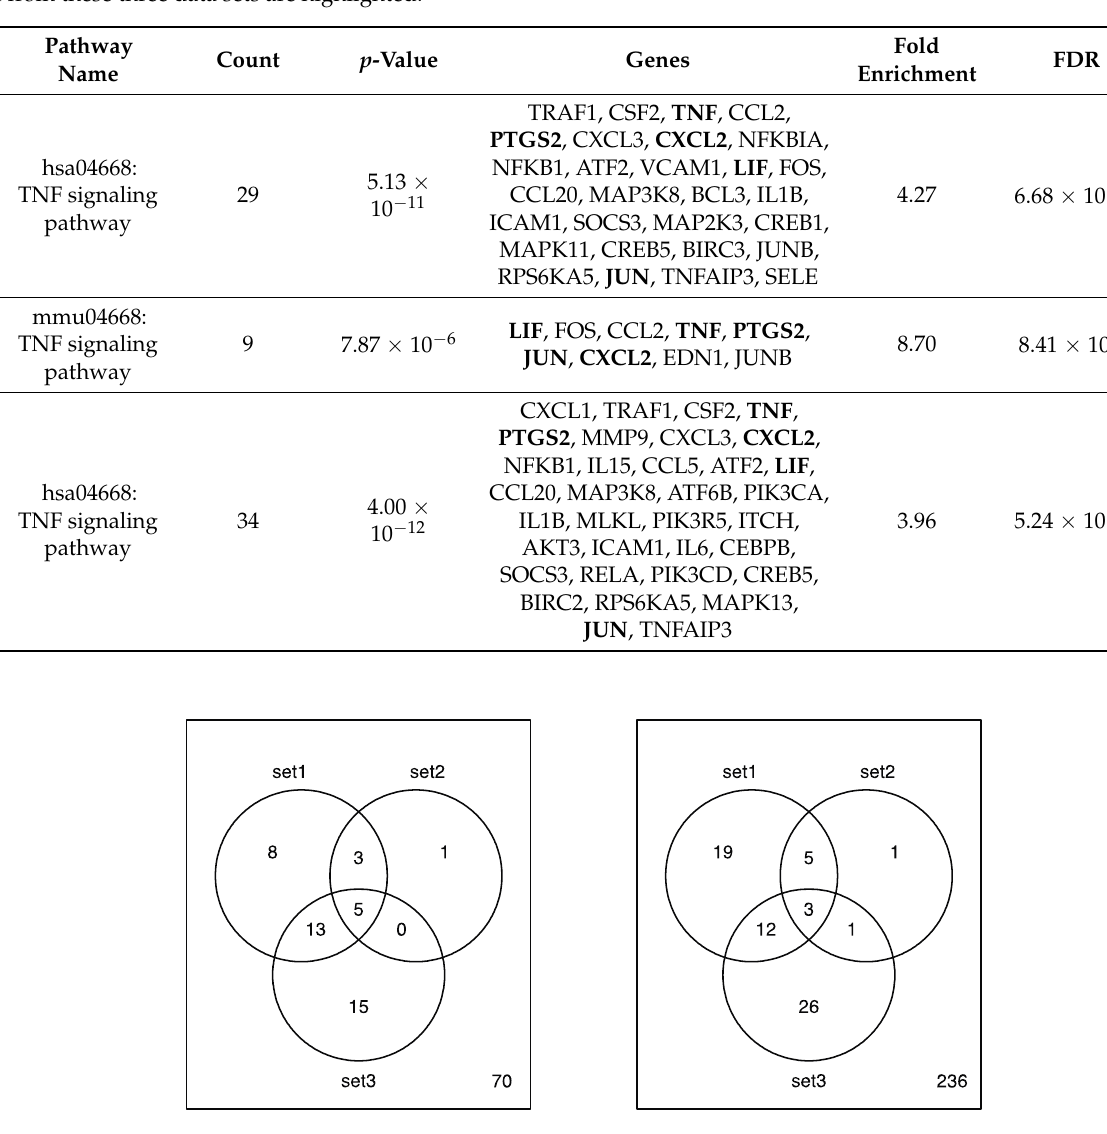
Table 2. TNF signaling Pathways identified from up-regulated genes from three microarray data sets. Common genes identified from these three data sets are highlighted.